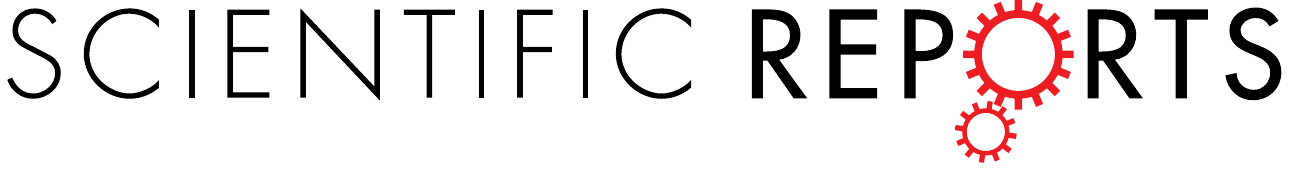
trates the schematic diagram of TPD-DH in microscopy. In the path of object wave, a test specimen, such as a micro-lens array, is placed in the front focal plane of microscope objective MO . After passing through the sample, the object wave was magnified by a telescope system (comprised of a microscopic objective MO and an achromatic lens L ). In the path of reference wave, a neutral variable attenuator is used to adjust the intensity of the reference wave. A phase shifter is located after the telescope system and is used to perform phase shifting